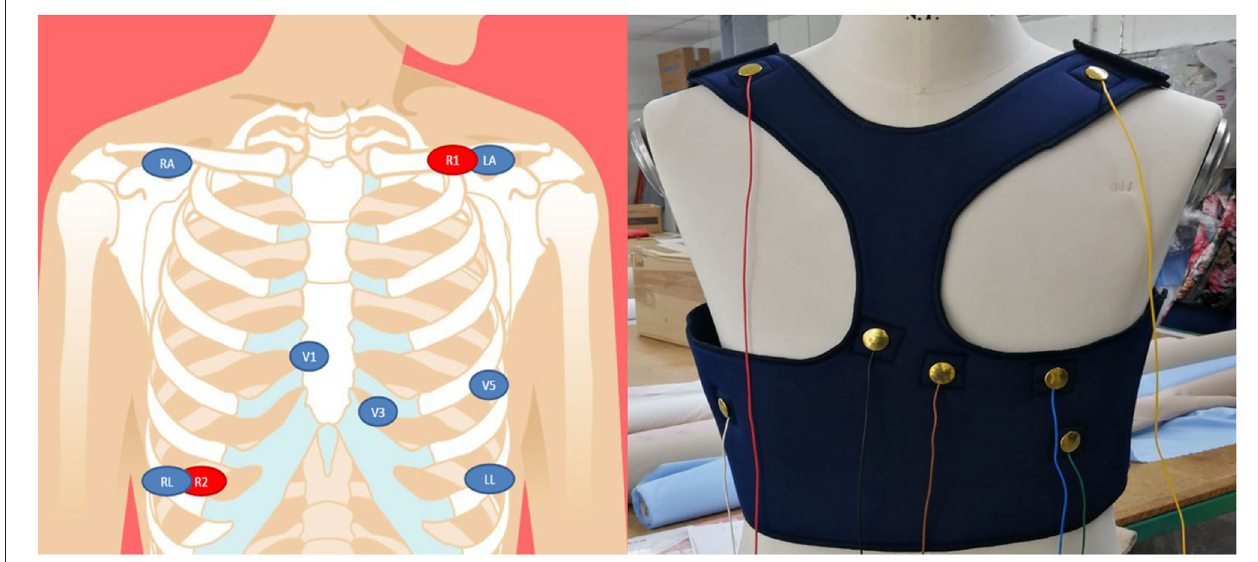
FIGURE 2 | On the left, the design for the positions of the biomedical sensors for the ECG and respiration; on the right, the frontal view of the first prototype of the ATTICUS S-WEAR.